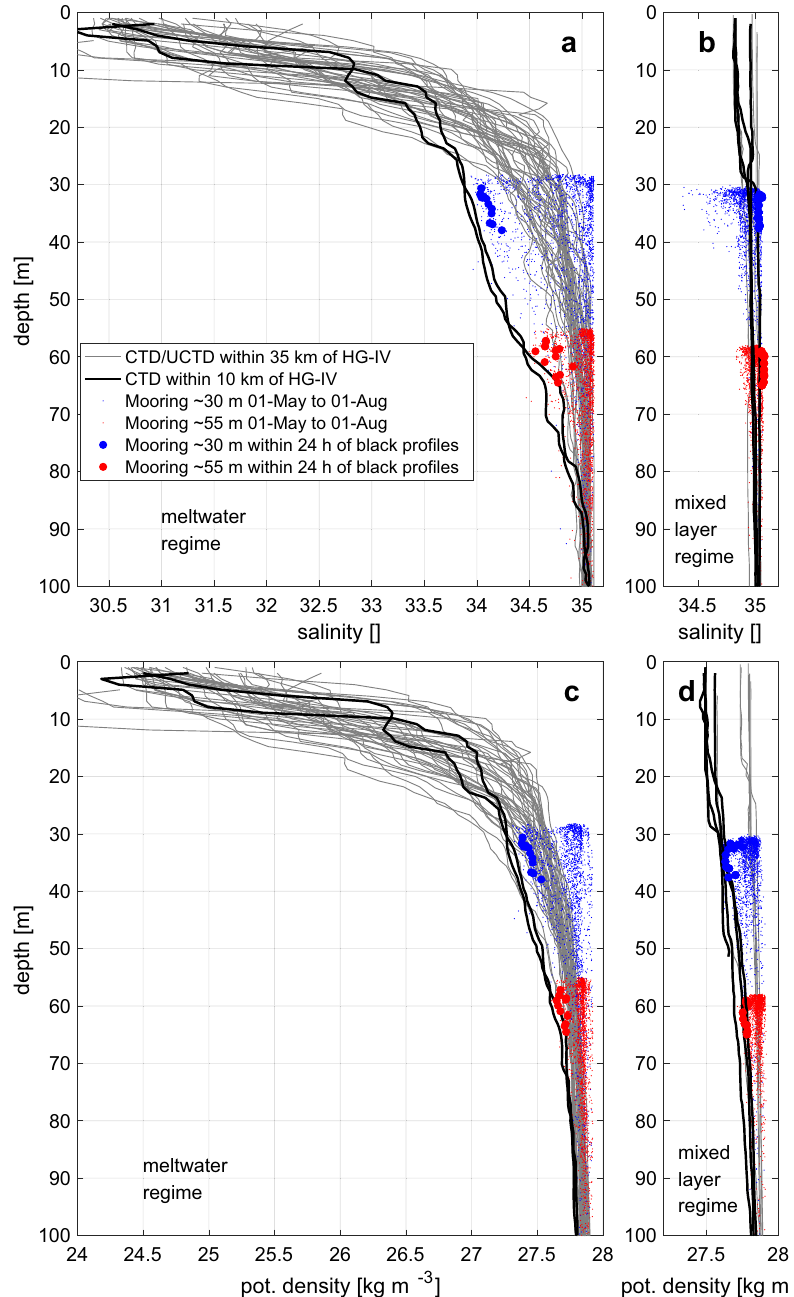
Fig. 3 Upper ocean strati fi cation from comparison of shipboard and mooring data. a , b Salinity [] and c , d potential density [kg m − 3 ] in 2017 (meltwater regime in a , c ) and 2018 (mixed layer regime in b , d ). All CTD/UCTD casts within 35 km of HG-IV mooring location (gray lines). All CTD casts within 10 km of HG-IV (black lines). All mooring measurements between 01-May and 01-Aug at ~30/~55 m (blue/red dots). Mooring measurements within 24 h of black pro fi les (large blue/red dots). Note that the aspect ratio of the subplots of the respective parameters is